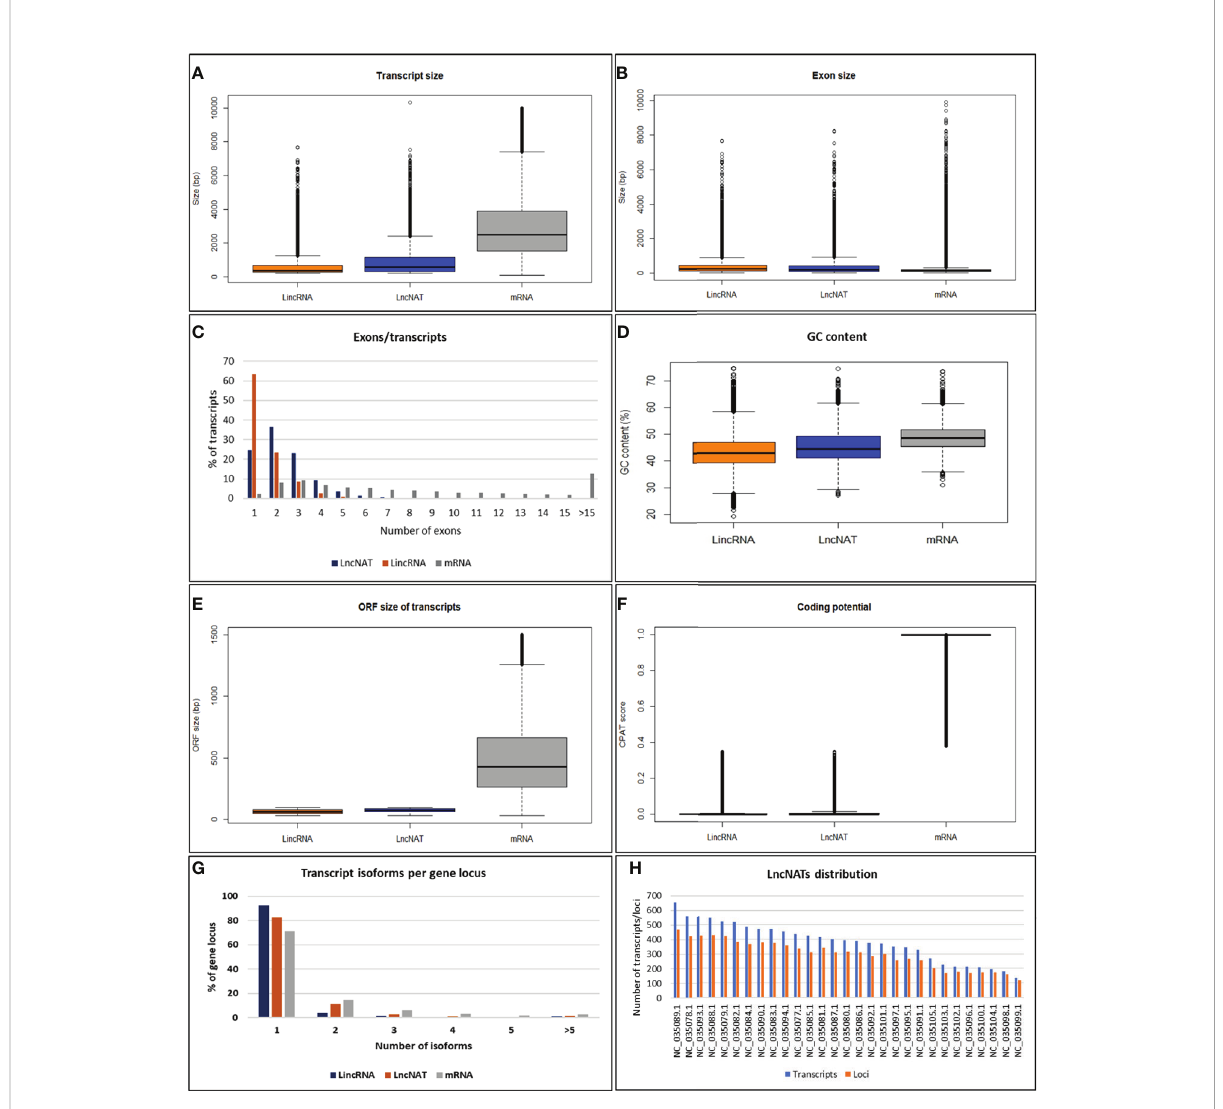
FIGURE 2 Genomic features of lncNATs compared to lincRNAs and mRNAs in rainbow trout. (A) The transcript size of lncNATs and lincRNAs is shorter than that of mRNAs. (B) The exon size of lncNATs and lincRNAs is longer than that of mRNAs. (C) LncNATs tend to have more exons than lincRNAs. (D) LncNATs have lower GC content than coding sequences but higher than lincRNAs. (E, F) LncNATs and lincRNAs have shorter ORF and lower coding scores than mRNAs. (G) LncNATs have fewer transcript isoforms per locus than coding sequences but more than lincRNAs. (H) Genomic distribution of